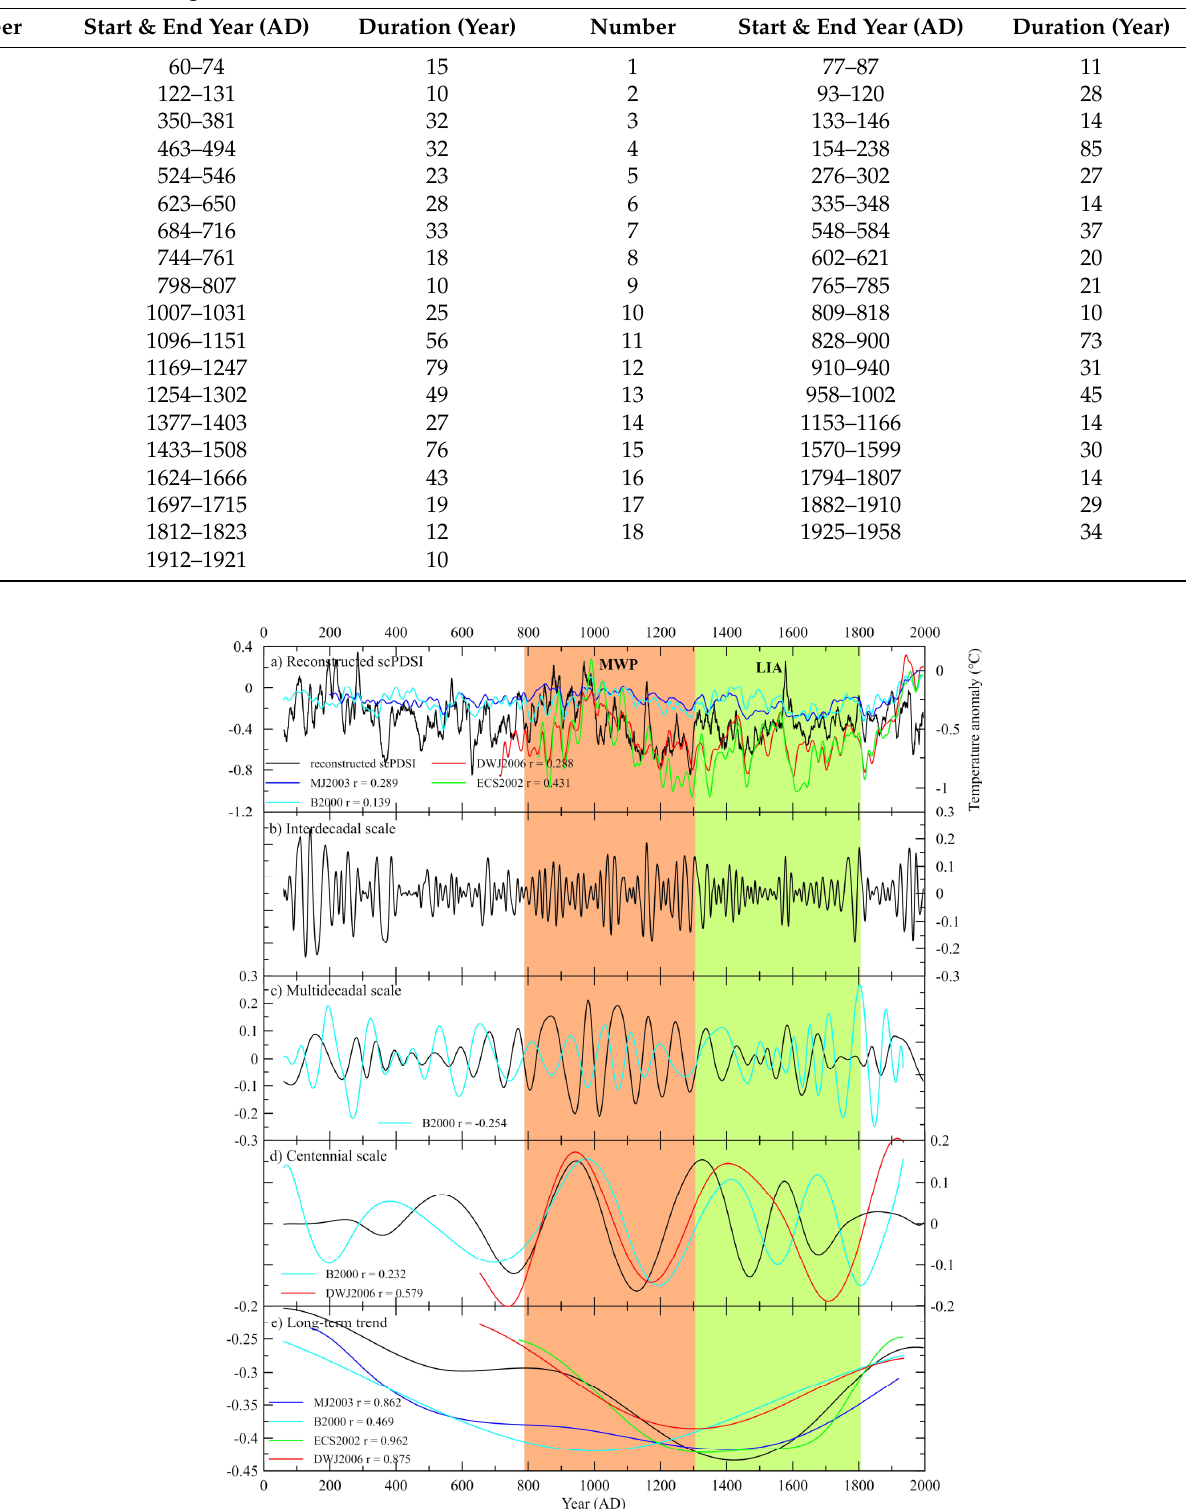
Figure 7. Comparison of the reconstructed scPDSI and four groups of temperature anomaly of the northern hemisphere over the past two millennia (AD 56–2000) using the empirical mode decom- position. Four different IMF components (i.e., interannual scale (<10 years), multidecadal scale (10~100 years), centennial scale (100~1000 years), and long-term trends (>1000 years)) were extracted and are shown in Figure 7. Based on the redfit function (which is part of Schulz’s REDFIT (version 3.8e) program and estimates the red-noise spectra of a time series in dplR, while the dplR (the Dendrochronology Program Library in R) is a package that en- ables dendrochronologists to handle data processing and analysis) in the package of “dplR” in R, red-noise spectral analysis was used to assess the oscillatory domains in these components. The dominant interannual variation was 5~10 years (Figure 7b), which was the strongest signal component in the original sequence. The correlation coefficient be- tween this component and the reconstructed scPDSI series was 0.353, which reflected the main high-frequency oscillation of the reconstructed sequence. Namely, there was a 5~10 years dry-wet cycle in China. Moreover, as shown in Figure 7b, the amplitude during the periods AD 56~400, AD 1000~1400, and AD 1900~2000 was greater, indicating that these 3 periods of dry-wet change were more intense. The dominant multidecadal variation was 30~50 years (Figure 7c). The amplitude was greater than other periods during AD 800~1300. We analyzed the correlation between M-scPDSI (multidecadal component of our reconstructed scPDSI) and B2000 (the multidecadal component of B2000), considering lags of different lengths of time (0~50 years, Figure 8). The calculation found that when the M-scPDSI and B2000 have a time lag of 15~40 years, the correlation is better (r > 0.1, p - value < 0.01). The positive correlation coefficient indicates that the dry-wet change of